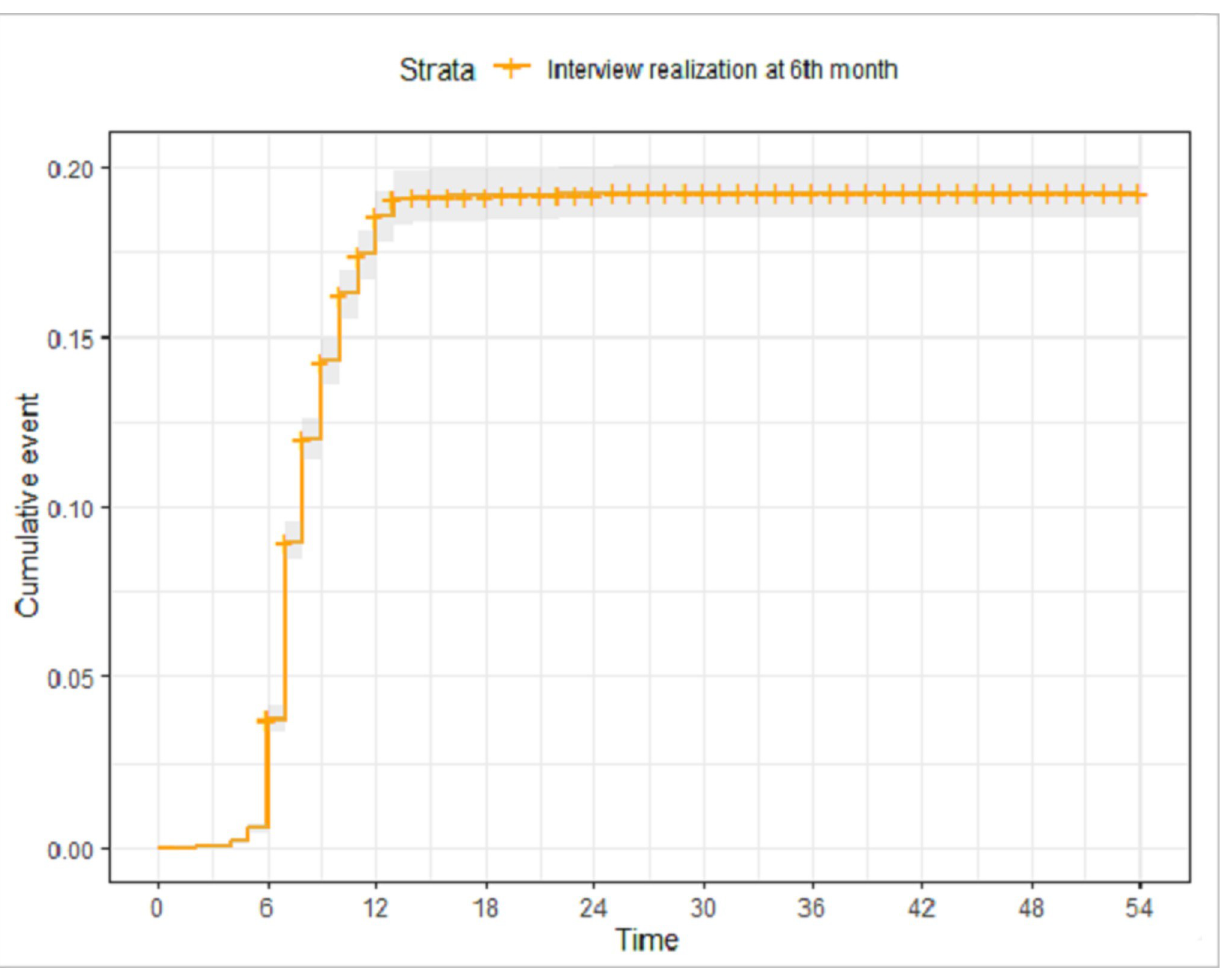
Fig 2. Interview realization survival analysis at 6M as a function of follow-up time in months.